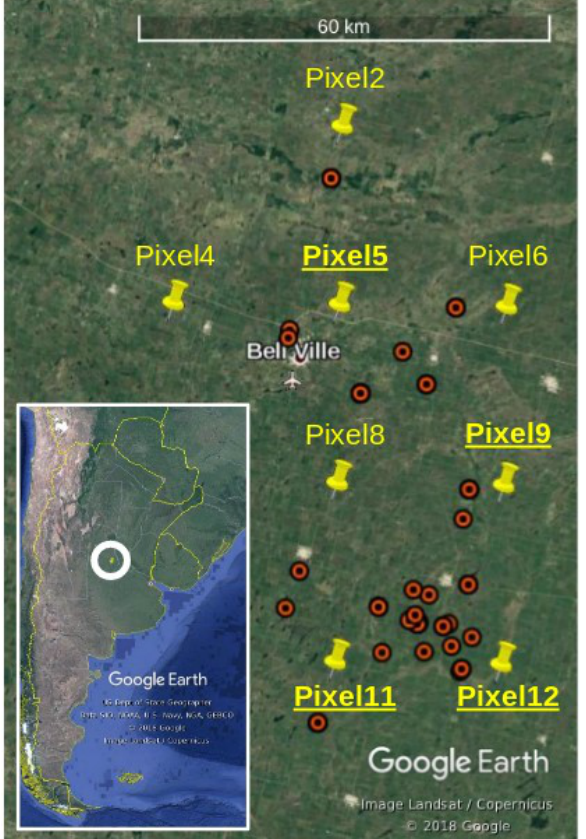
Figure 1. Region of study in central Argentina (white circle in the inserted map). Soil moisture sensors and chosen SMOS grid cells are indicated by red-black circles and yellow pins with assigned names respectively. Bold and underlined SMOS names highlight those grid points with the higher number of